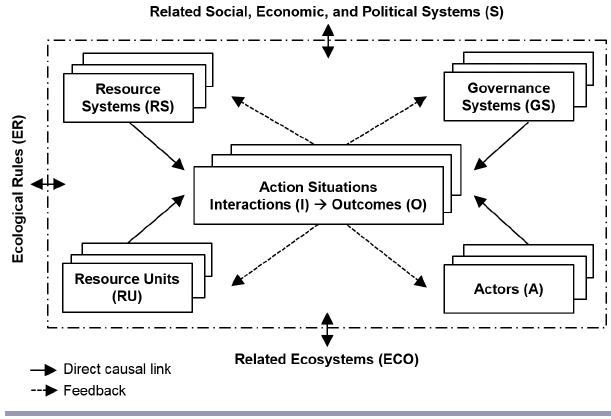
Fig. 1 . The social-ecological system framework consists of four core subsystems (RS, RU, GS, A) organized around a central action situation in which interactions occur and outcomes are produced. Additional subsystems (S, ECO, ER) impact all core subsystems. Figure is based on Ostrom (2009) and Epstein et al.